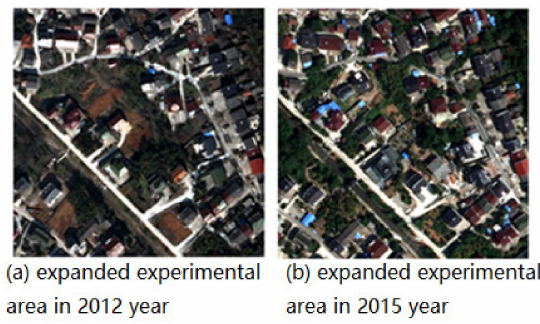
Figure 15. Expanded experimental